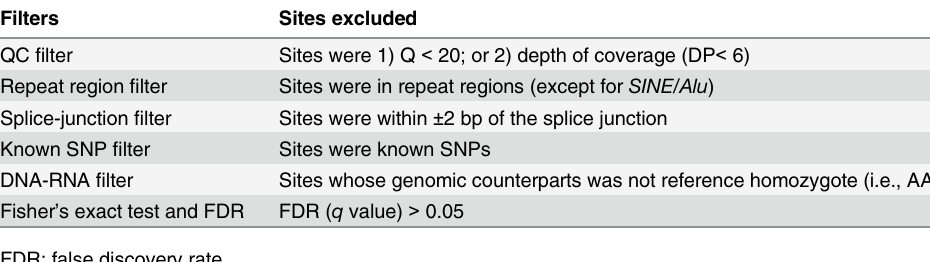
Table 1. Measures used for filtering spurious RNA editing